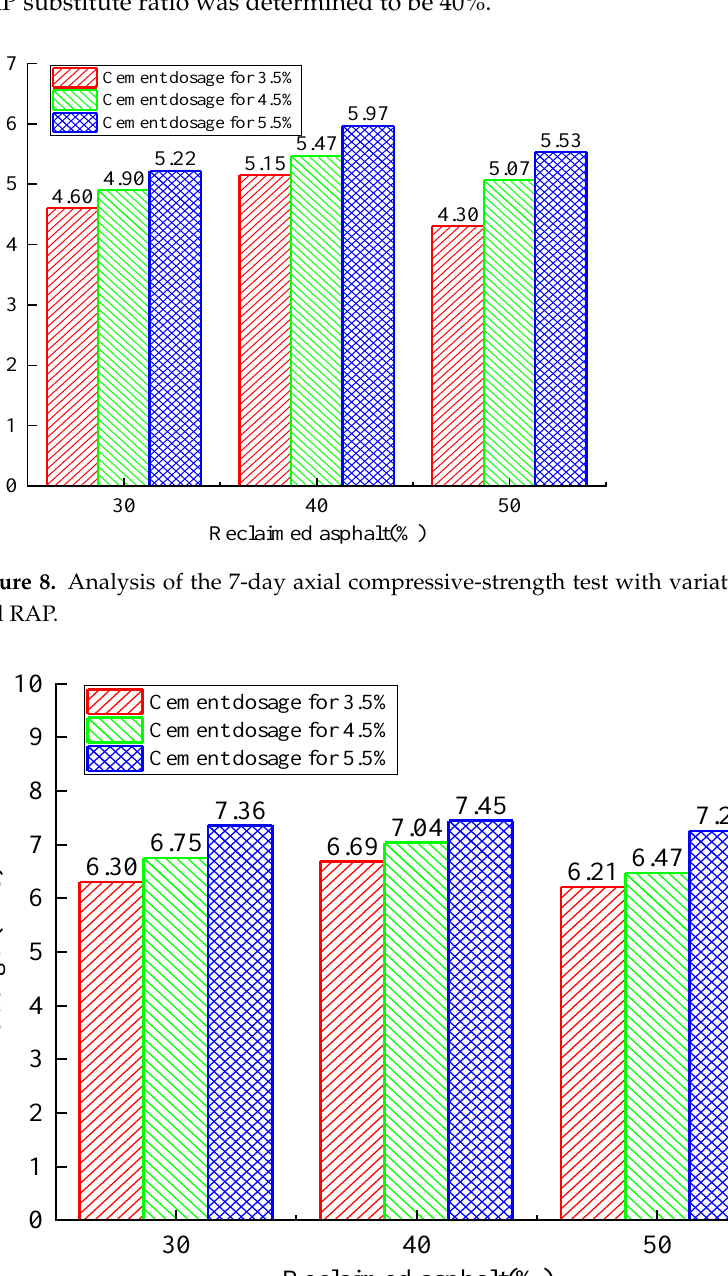
Figure 7. Reclaimed asphalt sieve analysis: ( a ) untreated RAP mixture; ( b ) extracted RAP mixture.